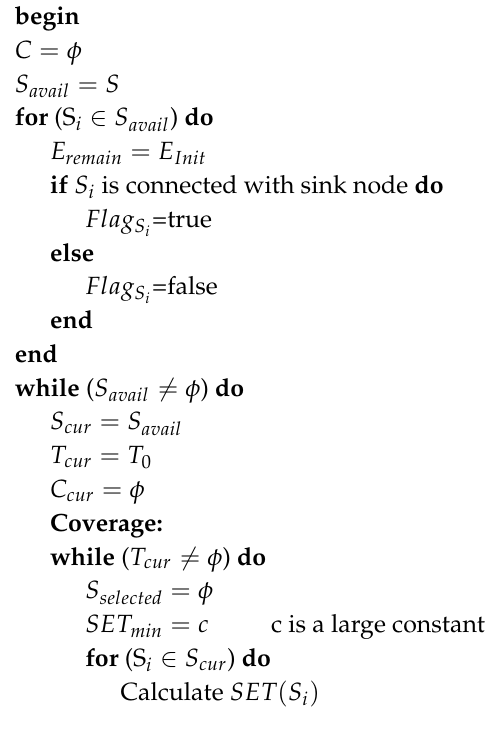
Algorithm 1. Centralized connected target k -coverage algorithm (CCTC k